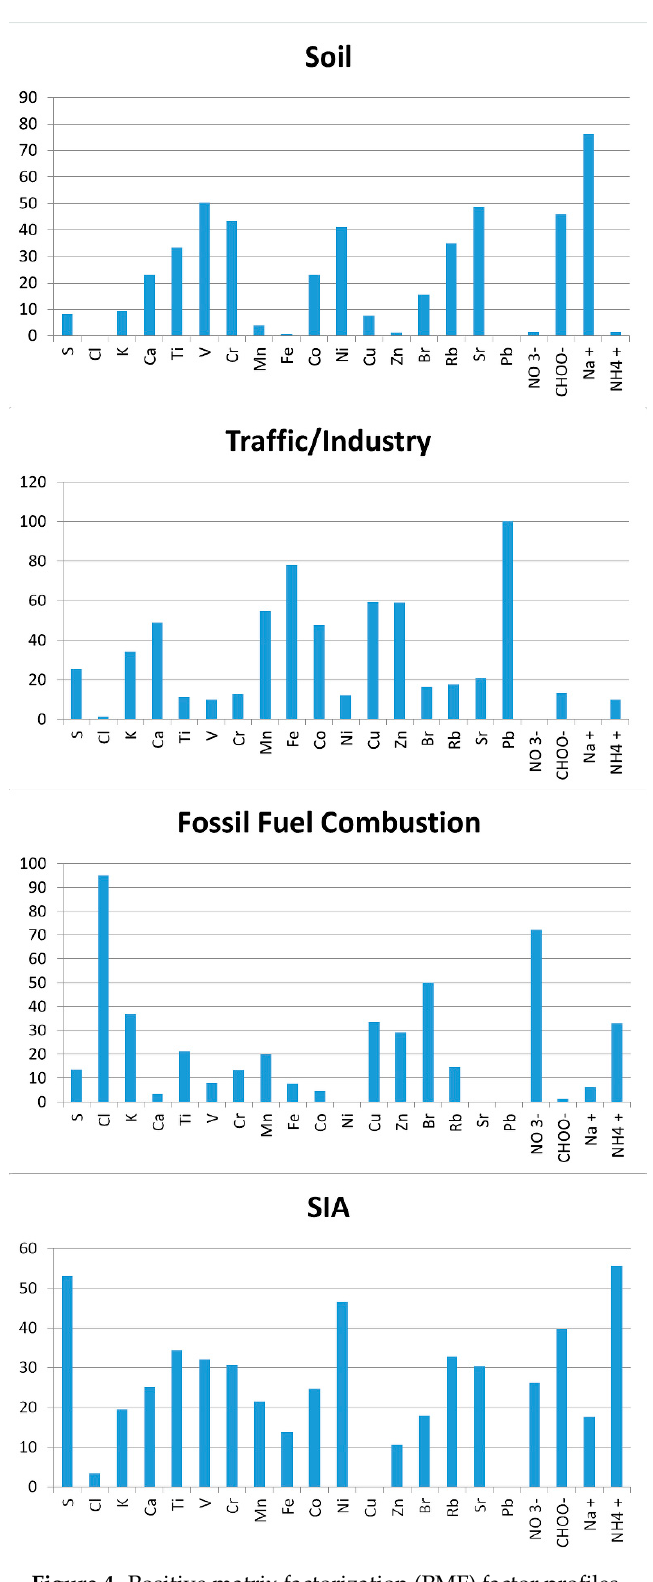
Figure 4. Positive matrix factorization (PMF) factor profiles.